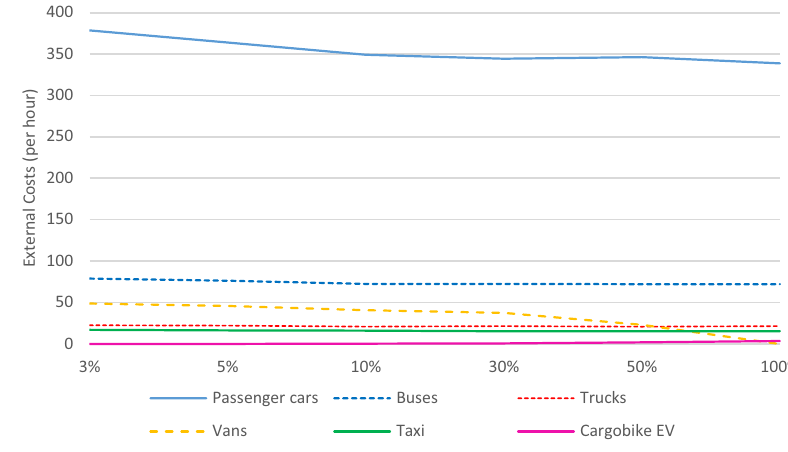
Fig. 6 External Costs of introducing electric cargobikes in the